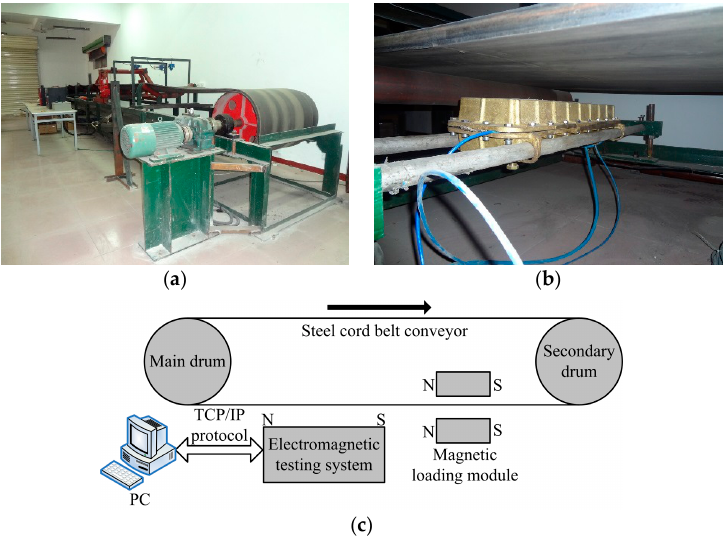
Figure 6. Electromagnetic testing rig of steel cord conveyor belt: ( a ) Tested belt conveyor prototype; ( b ) Installed electromagnetic testing device; ( c ) Electromagnetic testing system setup.